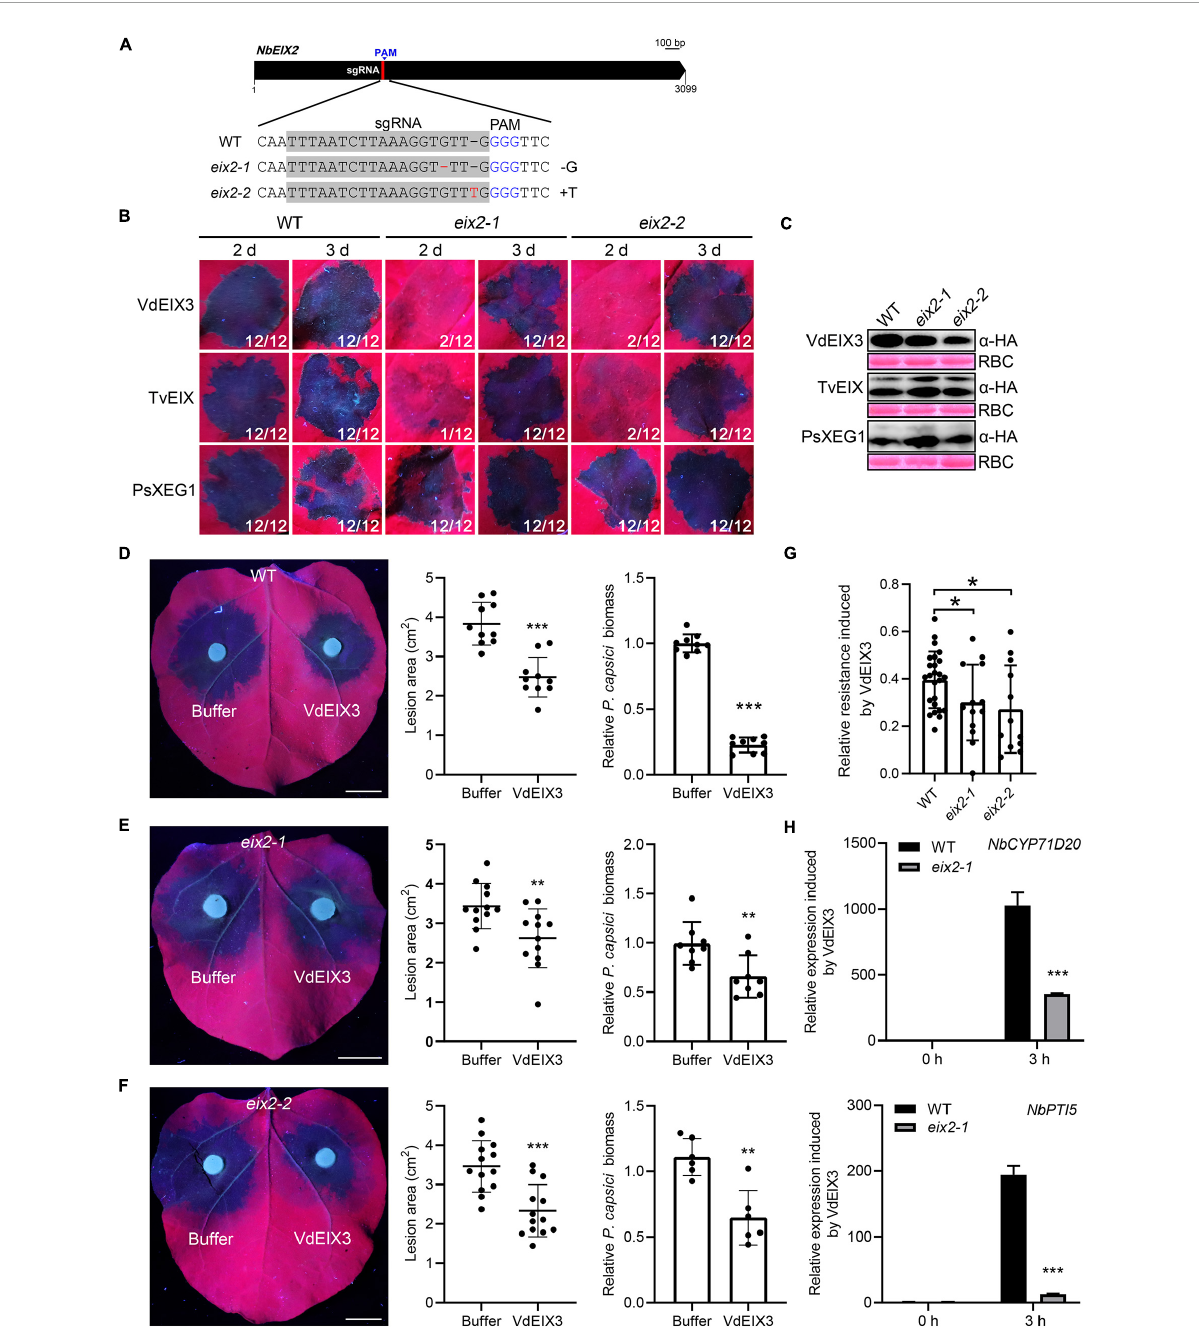
FIGURE2 VdEIX3-induced immune responses are impaired but not abolished in the eix2 mutants. (A) Sequence alignment of the region in eix2 targeted by sgRNA. The protospacer adjacent motif (PAM) is marked in blue, and the edited nucleotides are marked in red. (B) VdEIX3 and TvEIX induce delayed cell death in eix2 mutants. The photos were taken under UV light. (C) Proteins that were transiently expressed in Nicotiana benthamiana leaves were detected by immunoblot using anti-HA antibody. Ponceau S staining of Rubisco (RBC) indicates the loading control. (D–F) Pre-treatment of N. benthamiana leaves by 500 nM VdEIX3 for 24 h significantly promoted resistance to Phytophthora capsici in wild-type and eix2 mutants. Photos were taken 36 h post inoculation under UV light. Data are shown as mean ± SD (Student’s t -test, *** P < 0.001, ** P < 0.01). Bars, 1 cm. Relative P. capsici biomass in infected leaves was determined by qPCR (Student’s t -test, *** P < 0.001, ** P < 0.01). (G) Relative resistance-induced by VdEIX3 protein in wild-type N. benthamiana and eix2 mutants. Relative resistance is calculated by dividing (A,B) into A. (A,B) indicate lesion area of buffer-treated region and VdEIX3-treated region, respectively. Data are shown as mean ± SD (Student’s t -test, * P < 0.05). (H) Relative expressions of PTI (pattern-triggered immunity) marker genes induced by VdEIX3 protein in wild-type and eix2 mutants. Data are shown as mean ± SD (Student’s t -test, *** P <